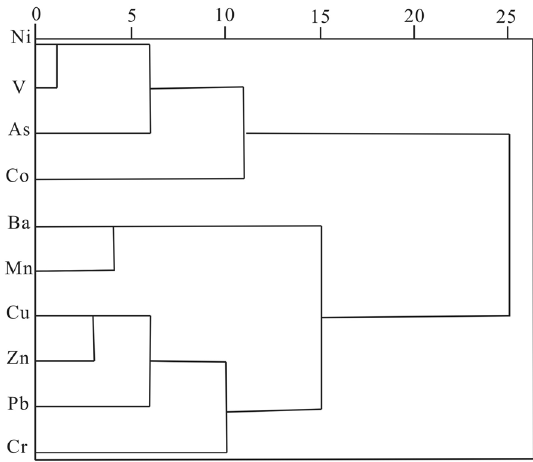
Figure 3. Dendrogram of cluster analysis for 10